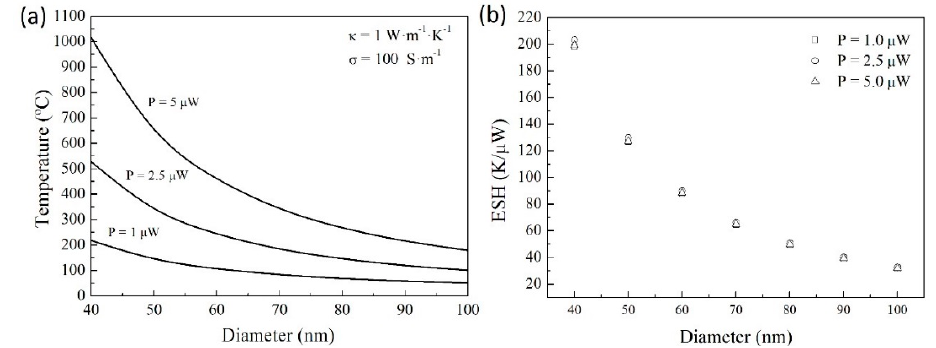
Figure 2. ( a ) Temperature reached at the center of the nanowire model, and ( b ) efficient self-heating coefficient (ESH) as a function of the nanowire diameter and the dissipated power with constant thermal and electrical conductivities. Reproduced from Ref. [40], with permission from Elsevier.